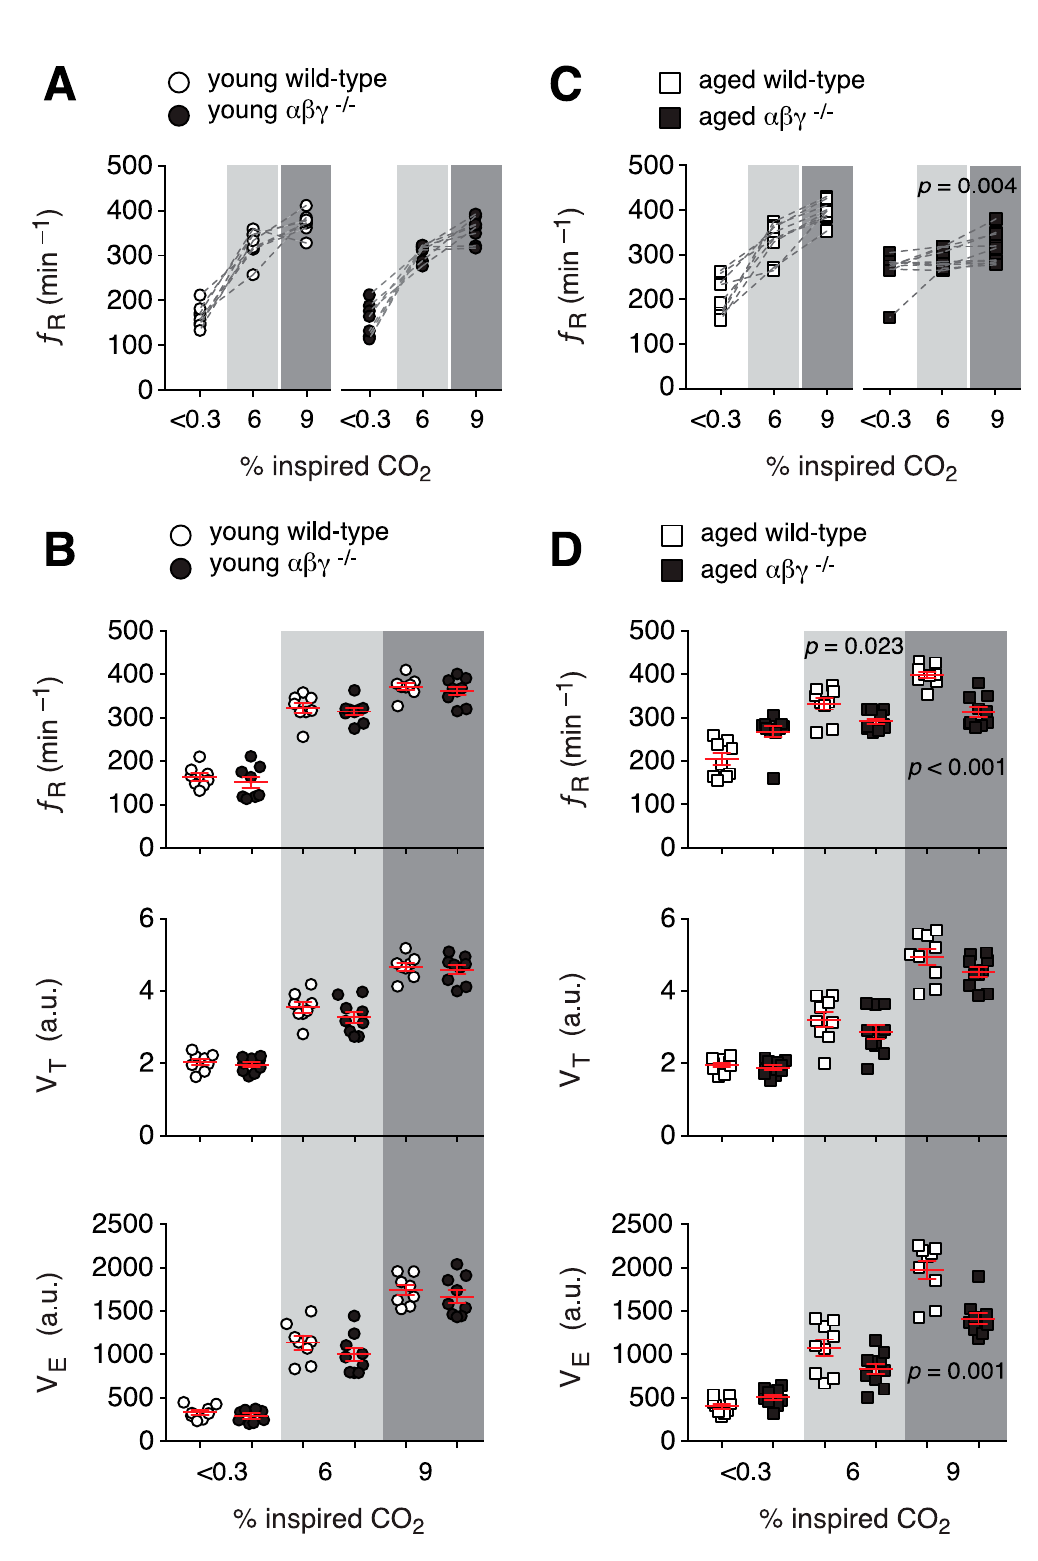
Figure 3. Respiratory responses of αβγ − / − mice to hypercapnia. ( A , B ) Group data from whole-body plethysmography measurements of respiratory rate ( ƒ R ), tidal volume ( V T ), and minute ventilation ( V E ) of unrestrained young wild-type and αβγ − / − mice in < 0.03% CO 2 , mild (6% CO 2 ), and moderate hypercapnia (9% CO 2 ). ( C , D ) Summary data from whole-body plethysmography measurements of breathing parameters ( ƒ R , V T , V E ) of aged wild-type and αβγ − / − mice in < 0.03%, 6%, and 9% CO 2 . p — Wilcoxon matched-pairs signed-rank test ( C ); Mann–Whitney U rank test ( D ).